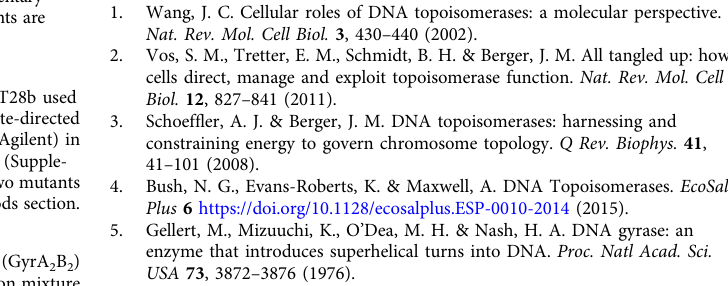
Table 2. The atomic models of the E . coli DNA-binding/cleavage domain in closed (with and without insertion) and pre-opening conformations have been deposited in the Protein Data Bank under accession numbers 6RKU, 6RKS, 6RKV, respectively. For the overall complex, we used a combination of different EM reconstructions to build the DNA gyrase overall complex atomic model. The ATPase-Core structure solved at 5.9 Å was used to rigid-body fi t in Chimera the ATPase domain crystal structure in complex with ADPNP 32 (PDB 1EI1) and the DNA-binding/ cleavage domain re fi ned in closed conformation. The quality of the electron density allowed to build in COOT the missing residues of the linker between the ATPase domain and the DNA-binding/cleavage domain. The CTD-Core structure solved at 6.3Å was used to accurately rigid-body fi t the β -pinwheel crystal structure 10 in Chimera. The 10 missing amino acids (564 – 574) following the GyrA-box